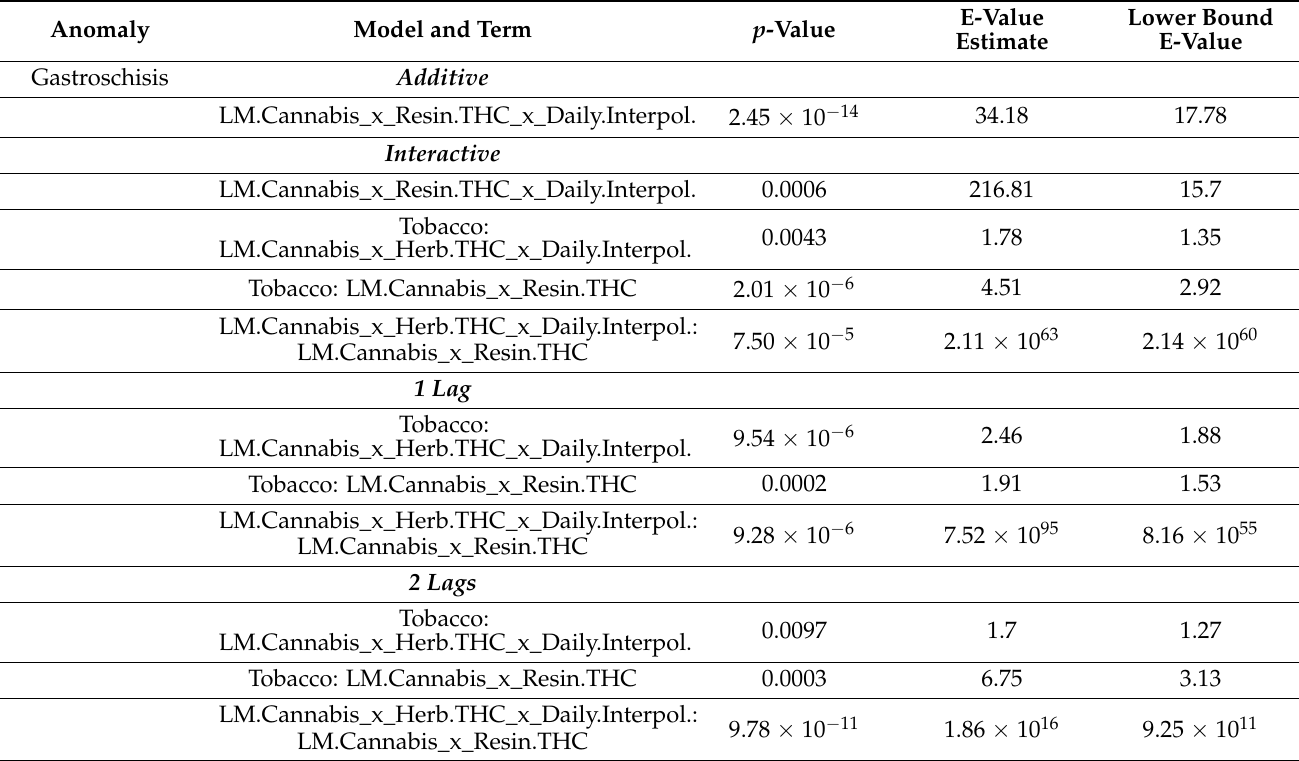
Table 5. E-Values from IPW Panel